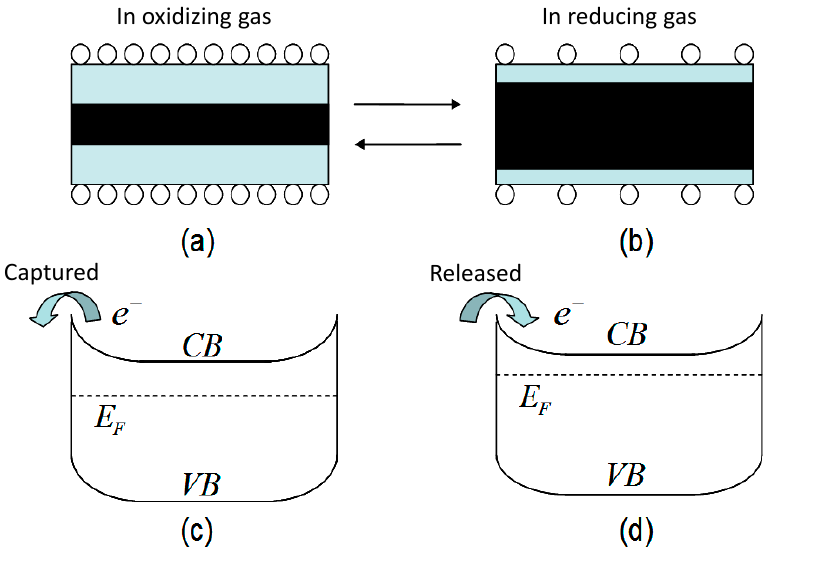
In reducing gasIn oxidizing gas